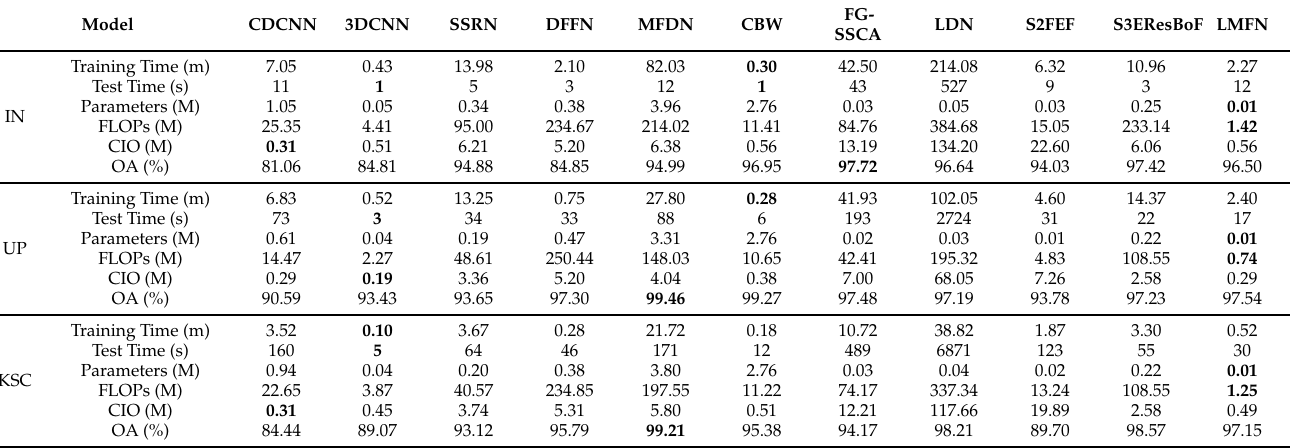
Table 5. Comparison of running time, parameter number, FLOPs, and CIO of different deep models on three datasets. OAs are provided here for comprehensive performance evaluation. The best results are highlighted in bold